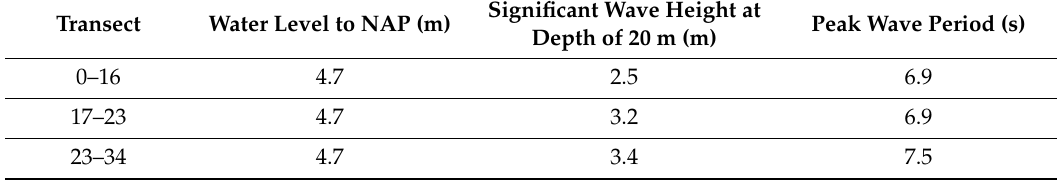
Table 2. Design conditions (return period 4000 years); (NAP = datum at 0.1 m below mean sea level).